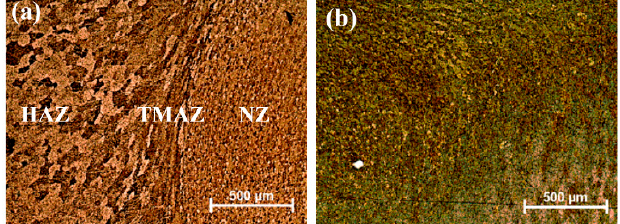
Figure 4. ( a ) Macrostructure at the cross-section of the joint marked with the distinct weld regions; ( b ) Micro-Vickers hardness map around the welded region of a naturally aged sample made by the RAFSW technique operated at optimized process parameters.